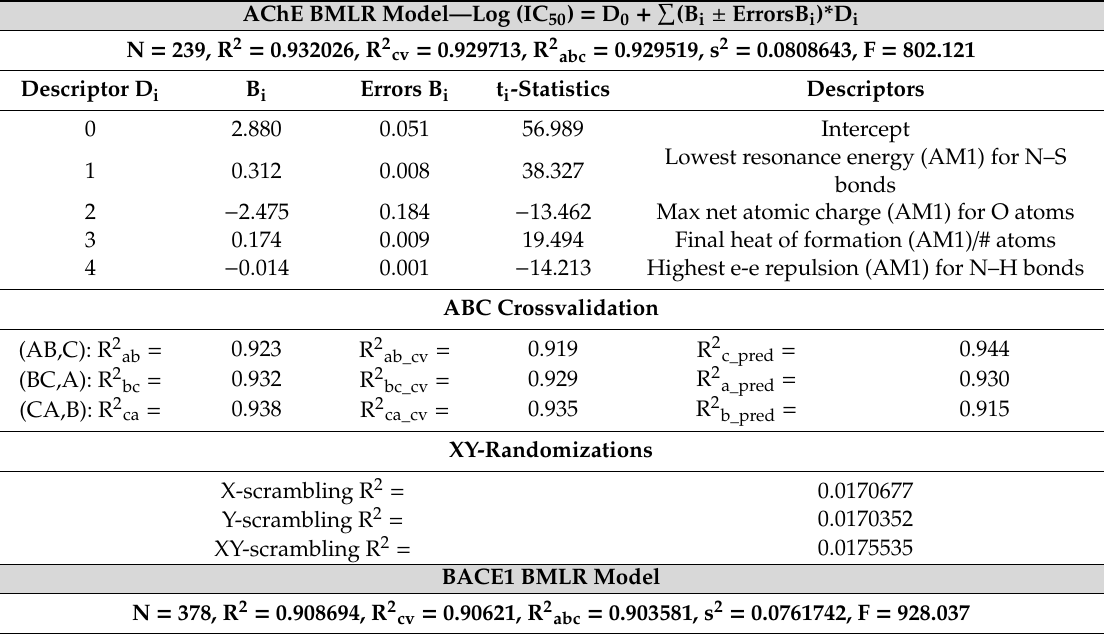
Table 1. Statistical parameters of the BMLR models for all four data